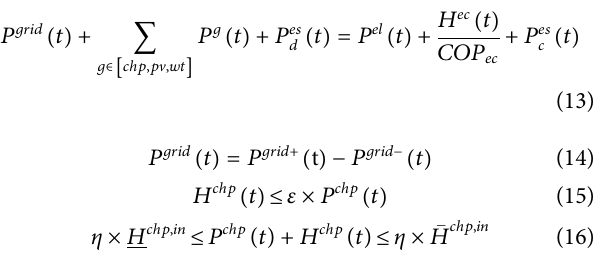
Frontiers in Energy Research |